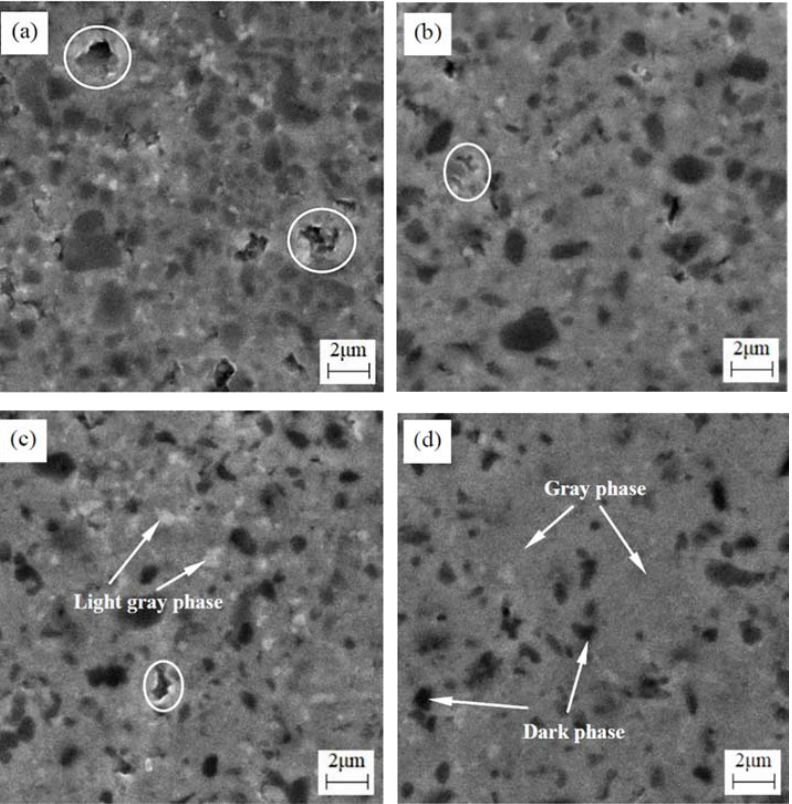
Figure 2. SEM micrographs of polished surfaces of TiC 0.7 N 0.3 -HfC-WC-Ni-Mo cermet tool materials with different WC contents: ( a ) TiC 0.7 N 0.3 -HfC-8 wt % WC (W8); ( b ) TiC 0.7 N 0.3 -HfC-16 wt % WC (W16); ( c ) TiC 0.7 N 0.3 -HfC-24 wt % WC (W24); ( d ) TiC 0.7 N 0.3 -HfC-32 wt % WC